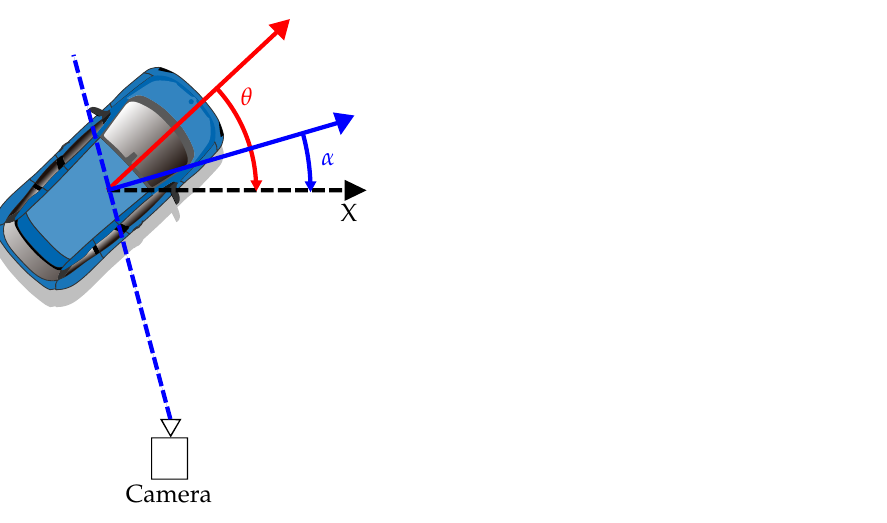
Figure 2. Illustration of the object azimuth θ and its observed orientation α . The local orientation is retrieved by computing the angle between the normal to the ray between the camera and the object center and the X-axis of the camera. Given that we are using left-hand coordinates, the rotation is clockwise. Our method estimates the observed orientation and θ can be obtained using Equation